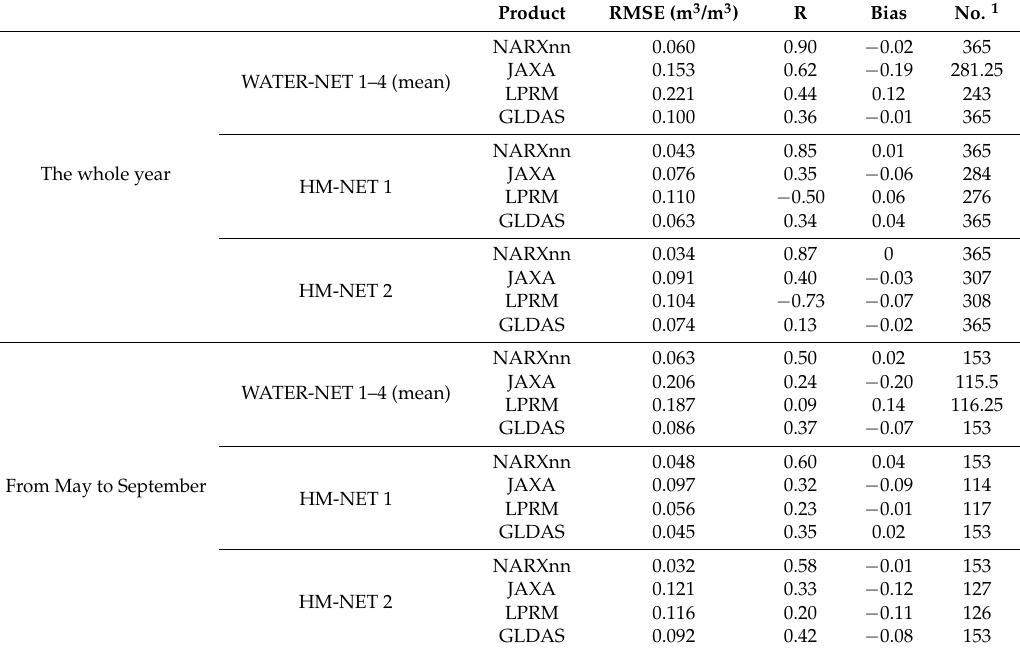
Table 3. Summary of soil moisture algorithm performance during the validation period